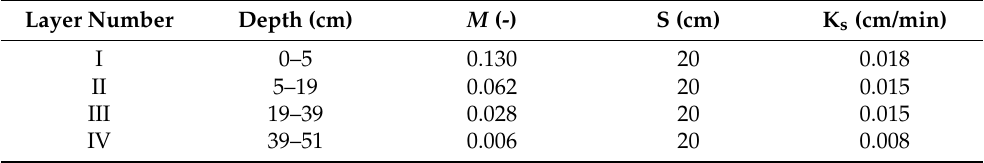
Table 3. Parameters of 20160808 runoff case using the multilayered G–A model.